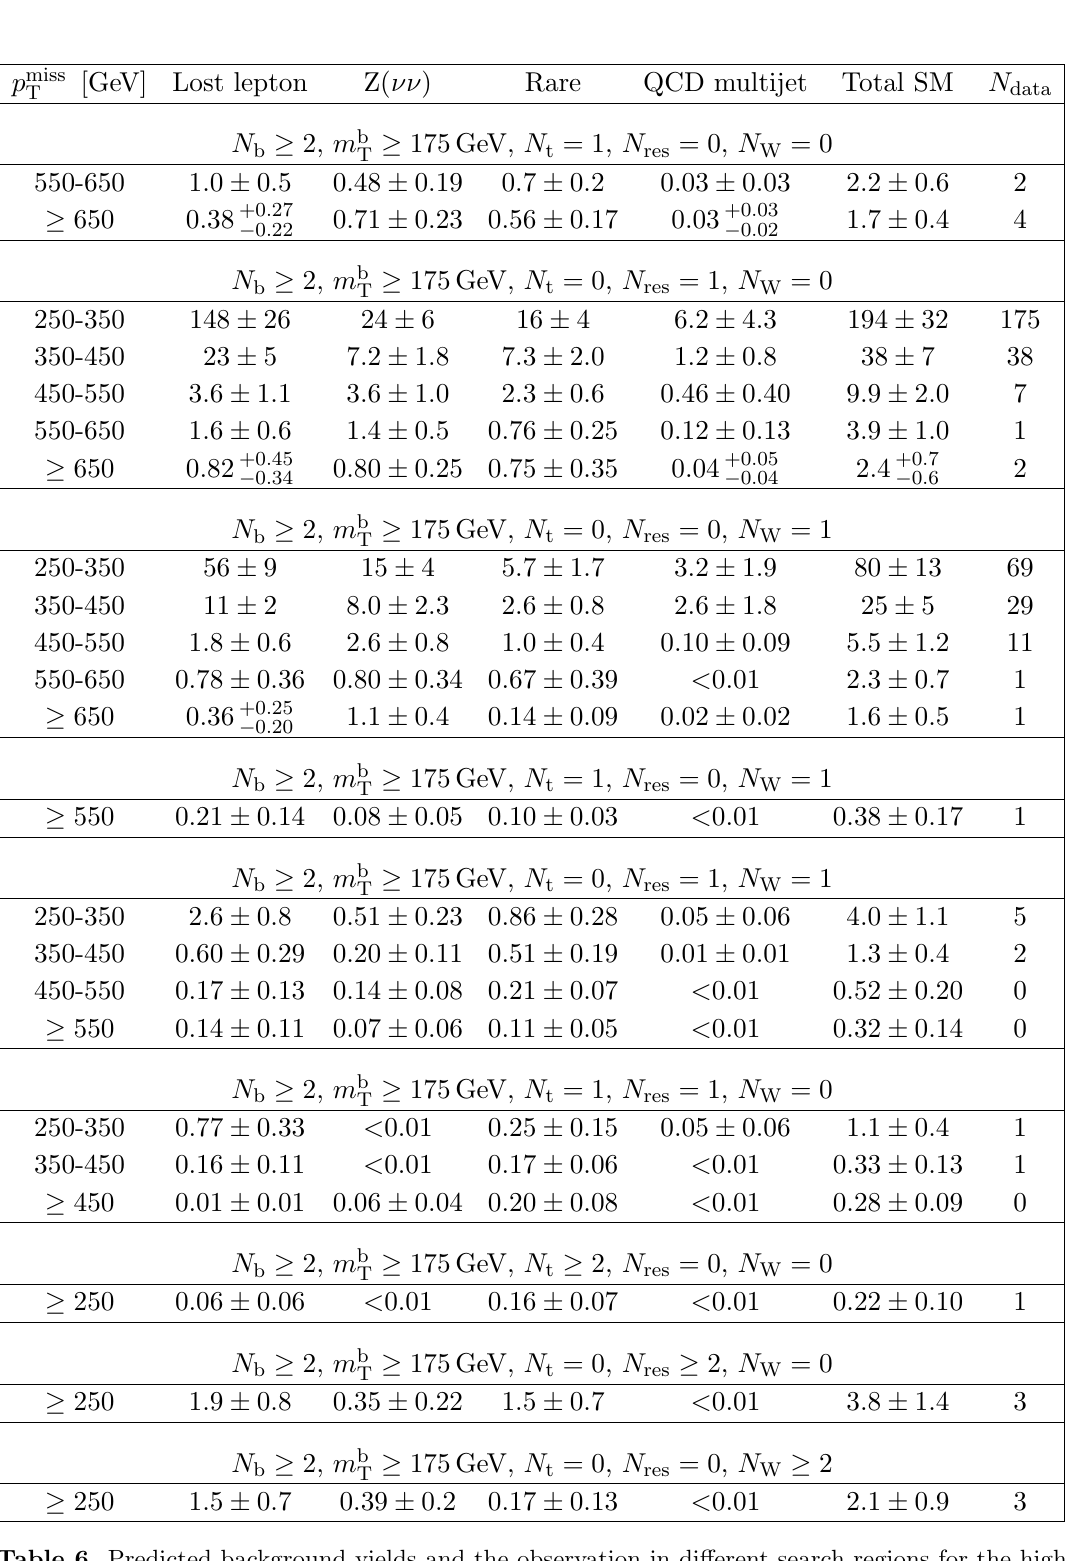
Table 6 . Predicted background yields and the observation in di(cid:11)erent search regions for the high (cid:1) m analysis. The total uncertainty is given for each background